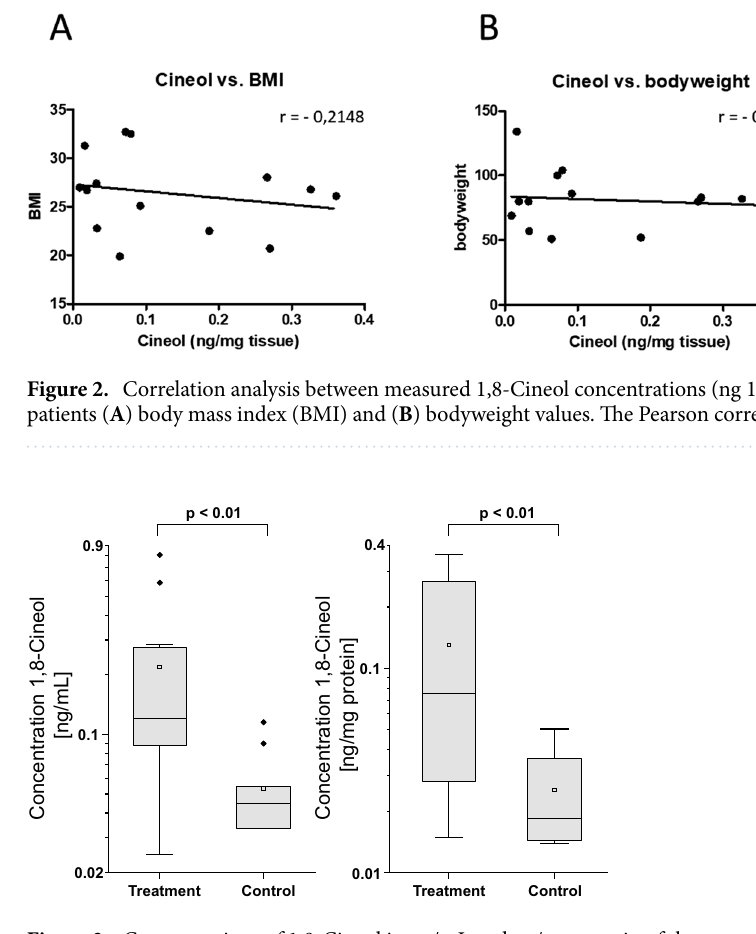
Figure 3. Concentrations of 1,8-Cineol in ng/mL and ng/mg protein of the treatment group and control group shown as boxplots. Significant differences were calculated by Mann–Whitney-U test and results are shown as p values. Concentrations below LOQ were set to ½*LOQ. Samples from control patients who used 1,8-Cineol medications contrary to agreement and samples from the treatment group who did not use the 1,8-Cineol medication regularly, were excluded from statistical